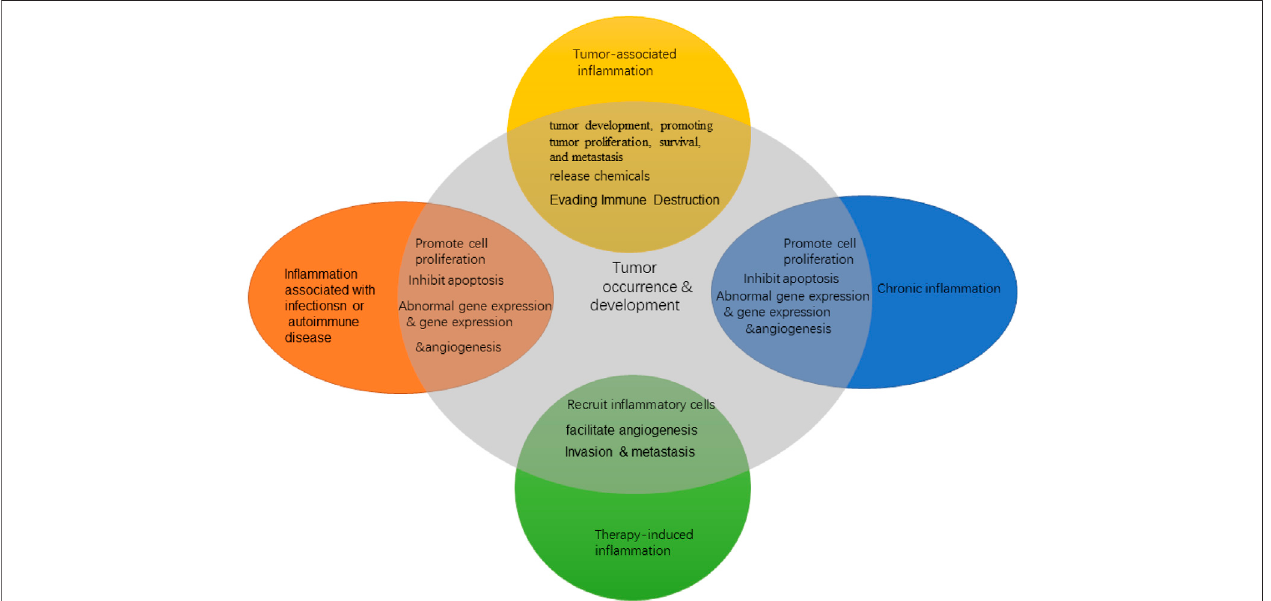
FIGURE 1 | In fl ammatory types in